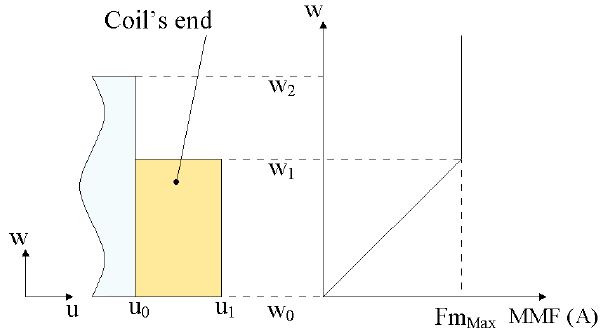
Figure 22. Magneto-motive force (MMF) coil variation.